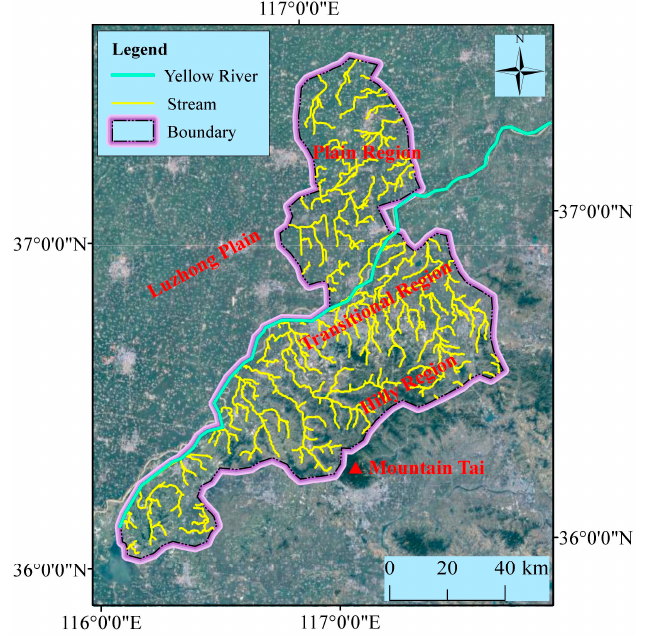
Figure 2. Topography surrounding Jinan.